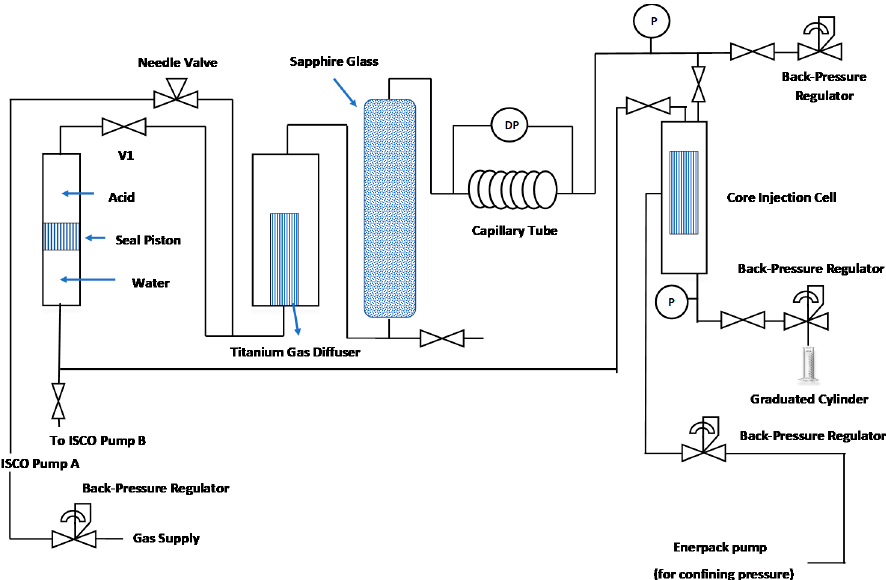
Figure 1. Schematic of the experimental apparatus.